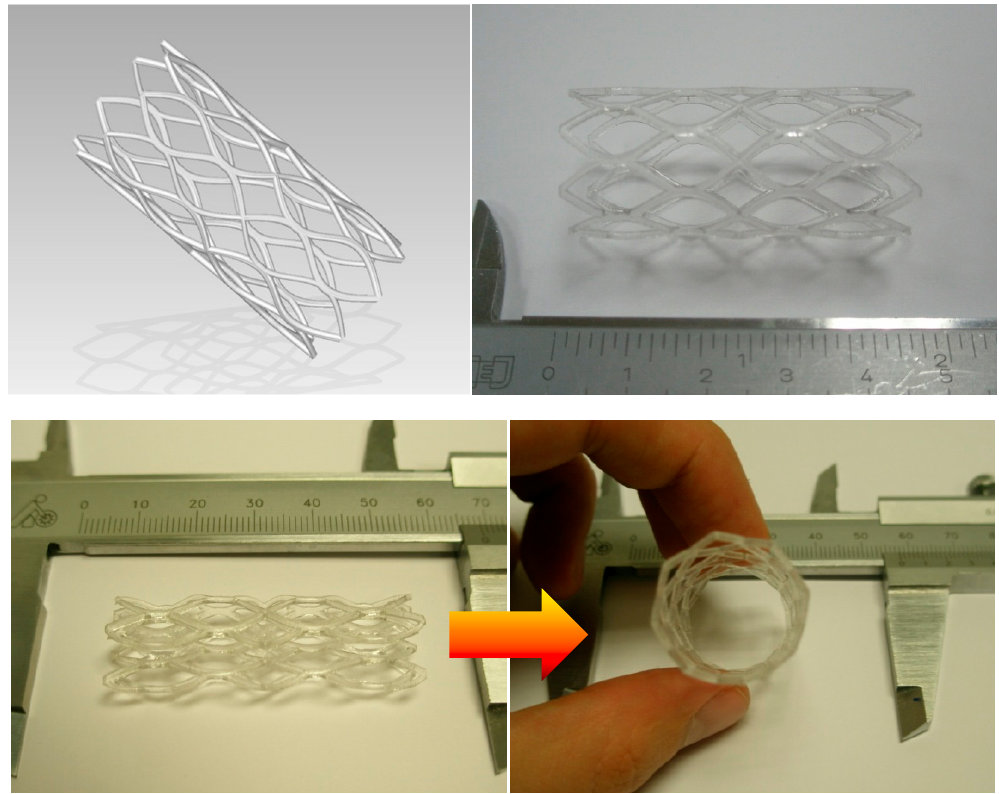
Figure 4. Computer-aided design of the complex geometry of a SMP-based stent, rapid prototype, compressed temporary shape and shape recovery by heating. Adapted from author’s Thesis [10].